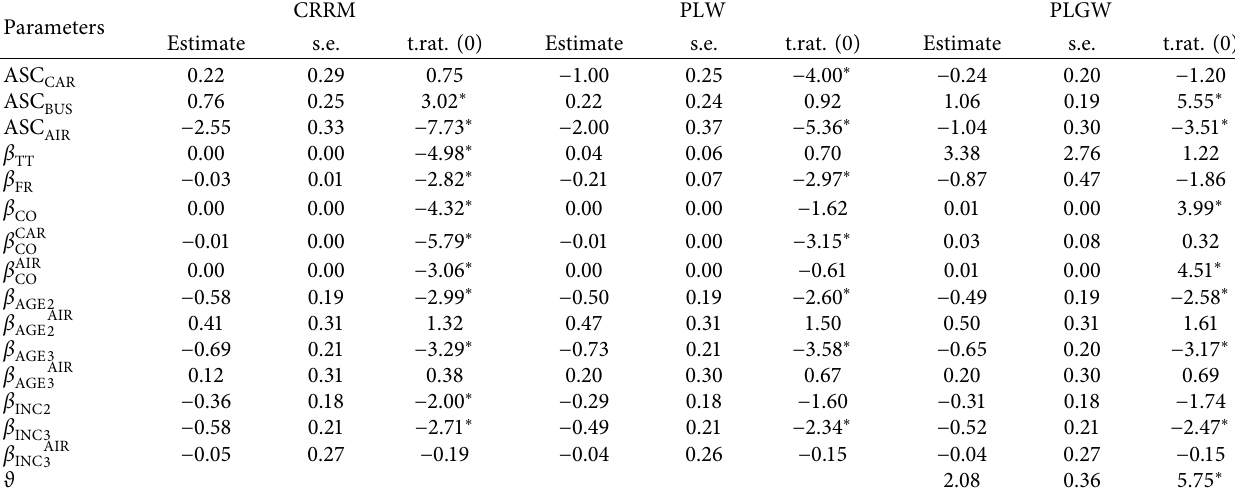
Table 10: Estimates of the CRRM, PLW, and PLGW for nonbusiness purpose of the CR experiment. Parameters